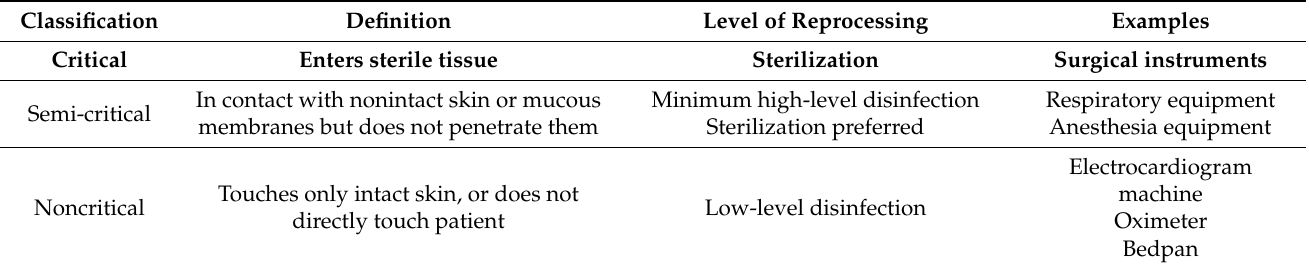
Table 1. The Spaulding criteria [13].